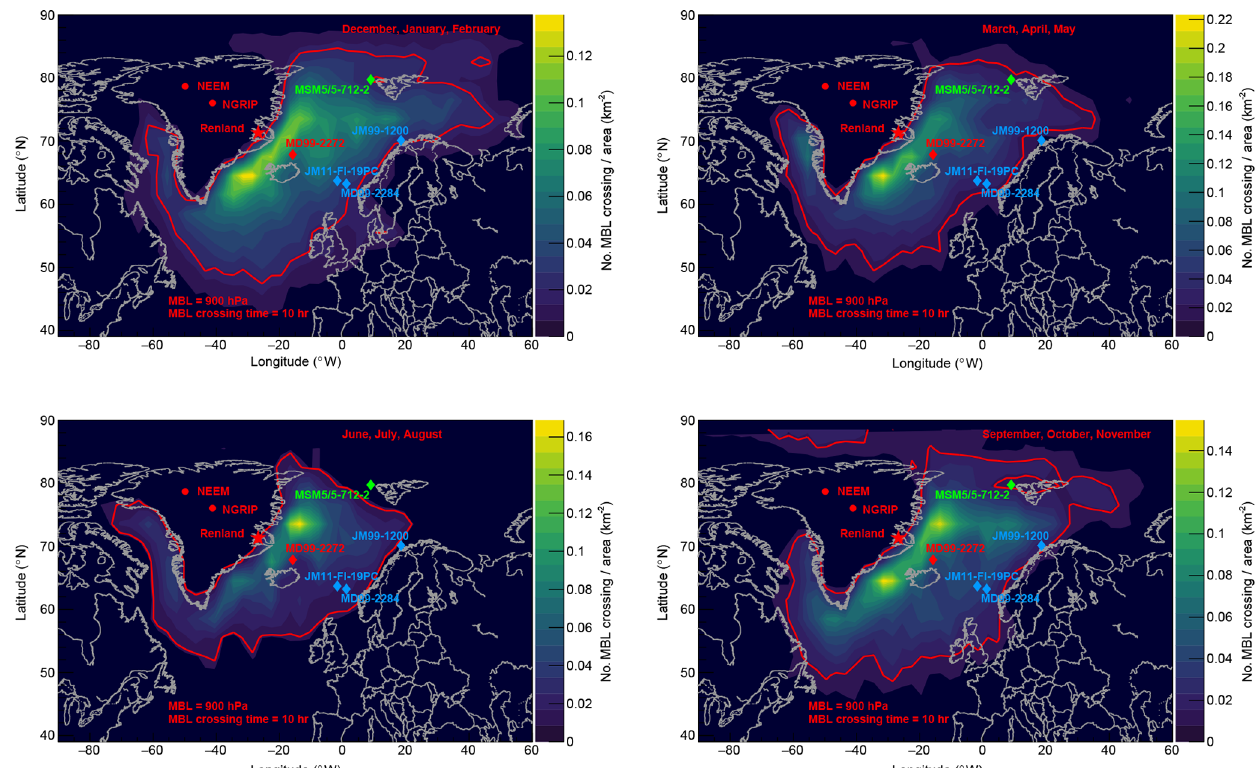
Figure 1. Modern (2000–2016) source region of atmospheric sodium and bromine deposited at the Renland site estimated from 3d back trajectory calculations. On the z axis is represented the number of marine boundary layer (MBL) crossings per unit area, derived by selecting only those trajectories which crossed the 900hPa isosurface for at least 10h (see Sect. 2.3). The red line contours 75% of the distribution integral, and it is considered to be the bromine and sodium source region. It covers the North Atlantic Ocean from ∼ 50 to 85 ◦ N. A minor contribution is expected from west Greenland waters. Note that areas outside the 75% line with counts < 0 . 02 crossingskm − 2 are not coloured. The analysis is performed on a seasonal basis. The Renland ice cap is marked with a star; the NEEM and NGRIP core sites are marked with a circle. The diamonds indicate the marine cores discussed in the text: Svalbard margin (MSM5/5-712-2, Müller and Stein, 2014), North Icelandic shelf (MD99-2272, Xiao et al., 2017) and the Norwegian Sea (JM11-FI-19PC, Hoff et al., 2016;